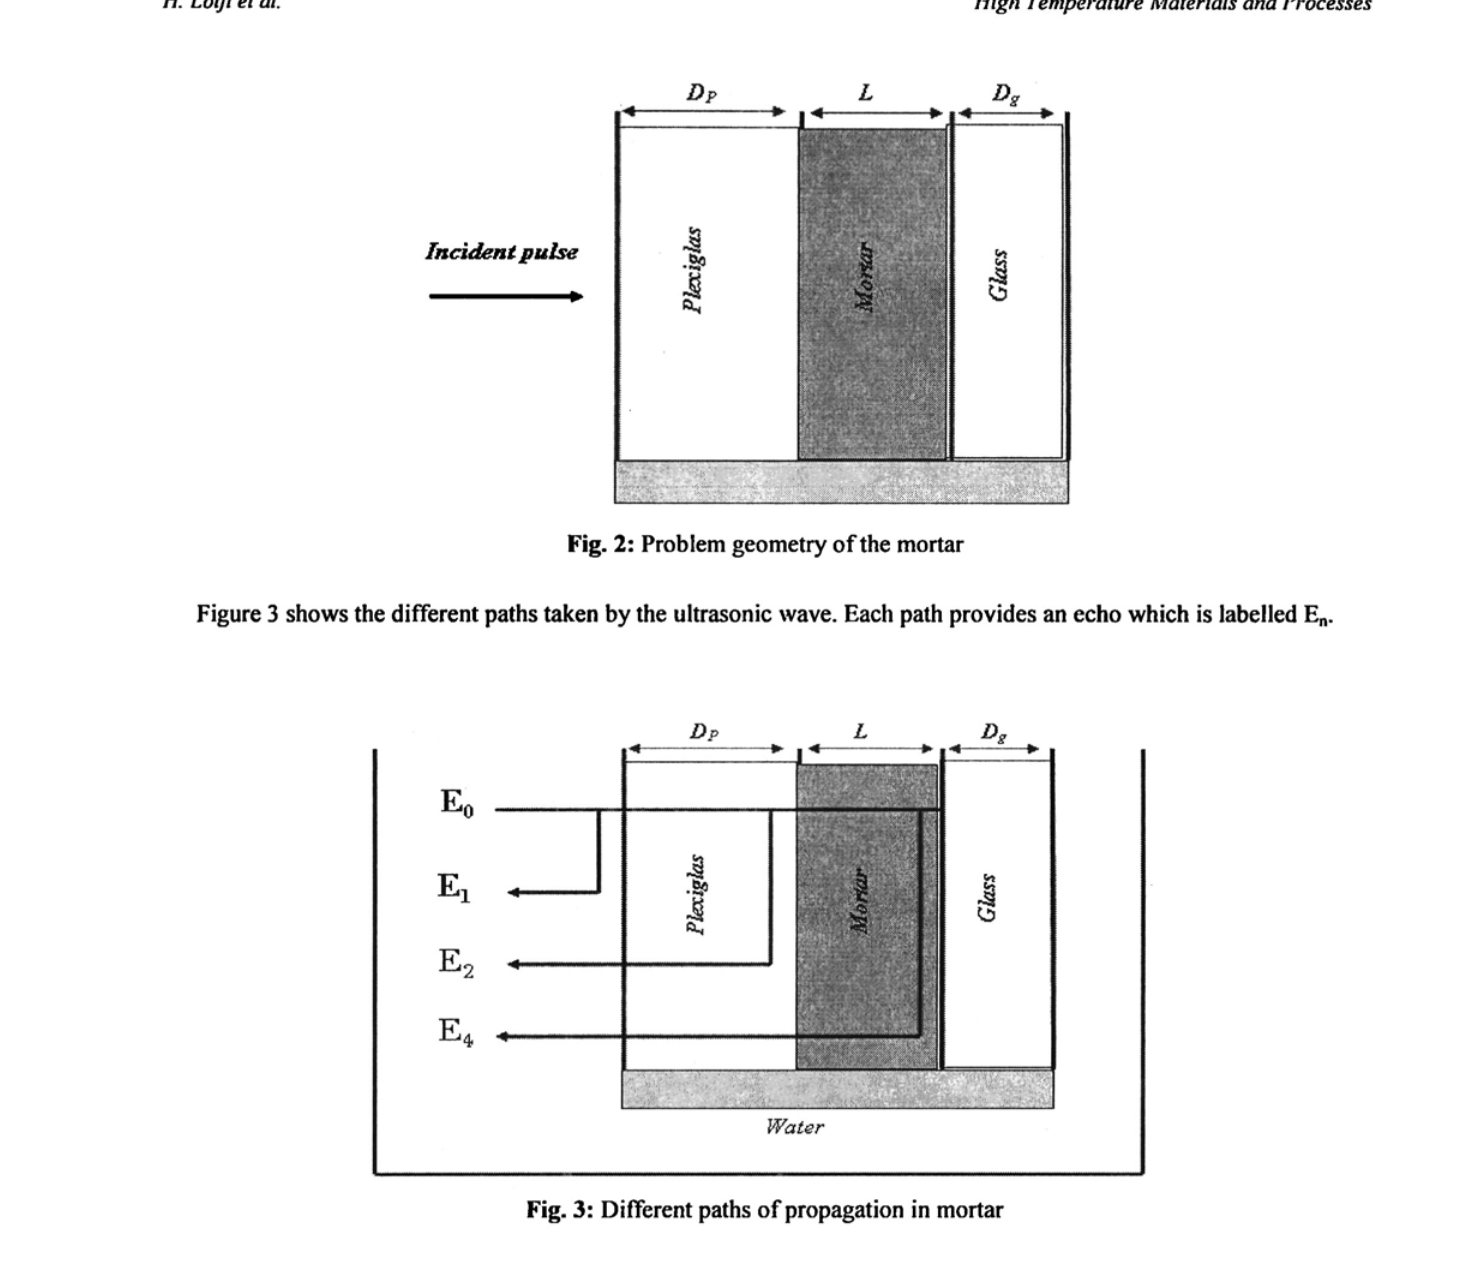
Fig. 3: Different paths of propagation in